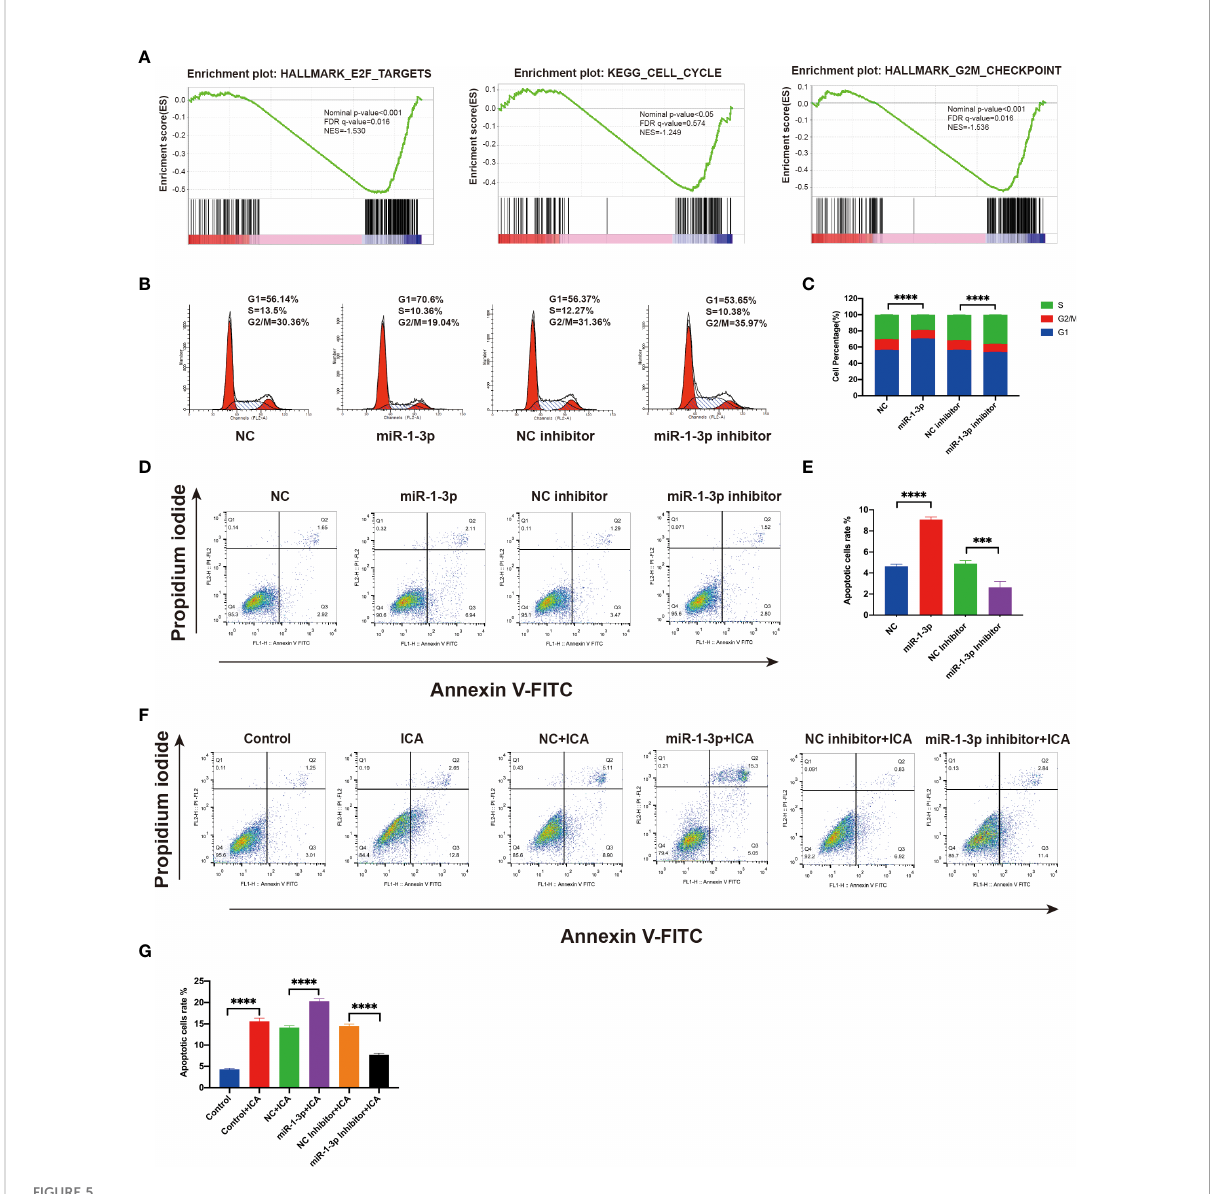
FIGURE 5 Icariin induces G1/S arrest and apoptosis in ovarian cancer cells by miR-1-3p/TNKS2/Wnt/ b -catenin axis. (A) GSEA plots showing downregulation of the genes associated with the cell cycle. (B) After transfecting SKOV-3 cells with mimic or inhibitor of miR-1-3p for 48 h, fl ow cytometry was applied to detect cell-cycle distribution. (C) Statistical analysis of the result from three independent assays, ***p< 0.001. (D) SKOV-3 cells were transfected with the mimic or inhibitor of miR-1-3p, and after 48 h, apoptotic cells ratio was assessed using fl ow cytometry after Annexin V-FITC/PI labeling. (E) Statistical analysis of the result from three independent assays, ***p< 0.005, ****p< 0.0001. (F) Apoptotic cells ratio was evaluated using fl ow cytometry following labeling with Annexin V-FITC/PI in SKOV-3 cells treated with 50 M icariin alone or in combination with miR-1-3p mimic or miR-1-3p inhibitor transfection for 48 h. (G) Statistical analysis of the result from three independent assays, ***p< 0.001, ****p<